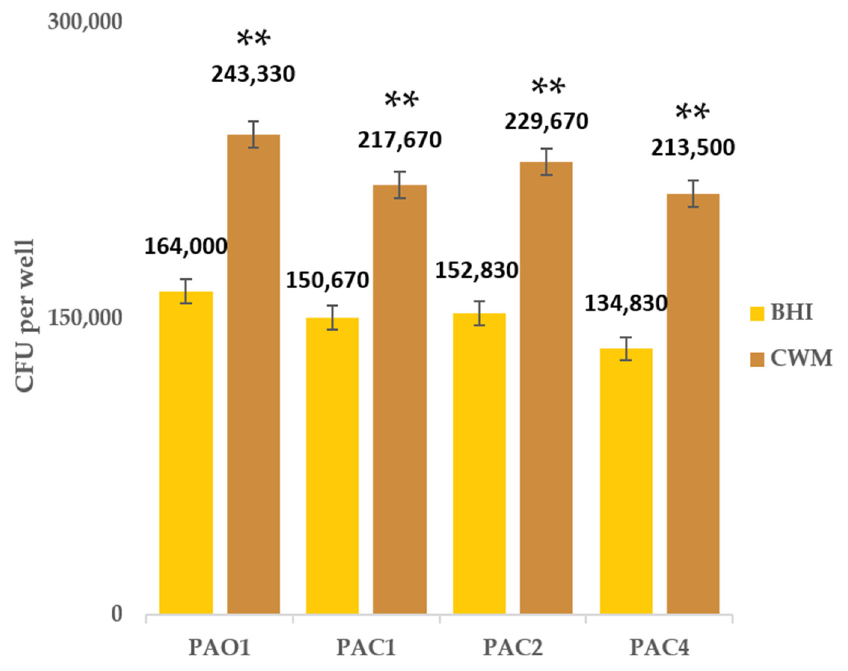
Figure 1. Mean living bacterial load after 72 h biofilm formation by P. aeruginosa strains (the reference strain PAO1 and three clinical strains, PAC1, PAC2 and PAC4) cultivated in two media, BHI and CWM. The average CFU per well was calculated from six independent experiments and determined by an automatic counting system. Results are presented as the mean ± standard deviation. Statistics were performed using a Wilcoxon Rank-Sum test using the R ® software in its 4.0.2 version to compare the difference in the mean bacterial load of each strain in two culture media. **, p < 0.01.